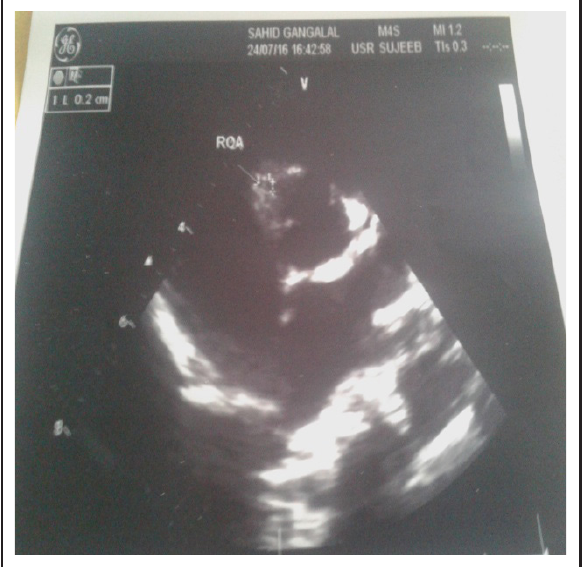
Figure 4. Normal size Right coronary artery in ECHO.